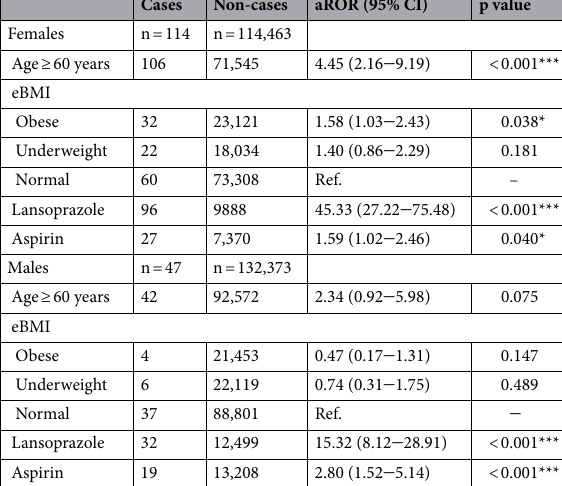
Table 3. Multiple logistic regression analysis of microscopic colitis using variables of drug and patient background for each sex. The adjusted reporting odds ratio (aROR) and 95% confidence intervals (95% CI) of microscopic colitis were calculated for sex, age, eBMI, lansoprazole and aspirin. eBMI estimated body mass index. ***p < 0.001, *p < 0.05, p: statistical significance obtained in multiple logistic regression analysis.